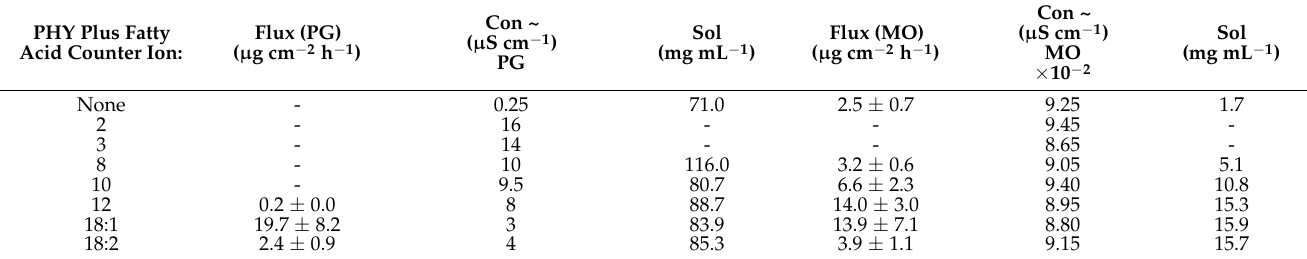
Table 11. Flux, conductivity (Con) and solubility (Sol) of PHY in PG and MO. According to the authors, saturated drug solutions were used in permeation experiments. Fatty acid counter ions are indicated according to length of carbon chain. 18:1 (OA, 1 double bond) and 18:2 (LA, 2 double bonds) (for conductivity and permeation experiments n = 3, values represent the mean ± S.D.) Adapted with permission from [39], Elsevier, 2005. PHY Plus Fatty Acid Counter